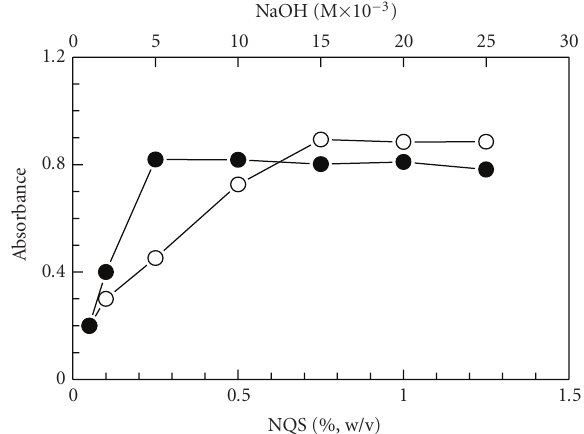
Figure 2: E ff ect of NQS ( • ) and NaOH ( ◦ ) concentrations on the reaction of PRX with NQS. PRX (40 μ g mL − 1 ): 1mL; NaOH: 1 mL; NQS: 1mL; temperature: 25 ± 5 ◦ C; reaction time: 10 minutes.